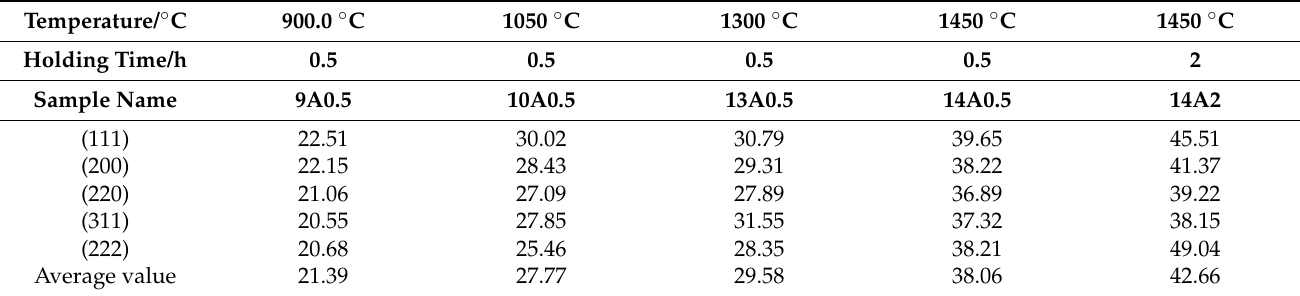
Table 2. Grain sizes of MgO calcined under different temperatures and cooled in air/nm.